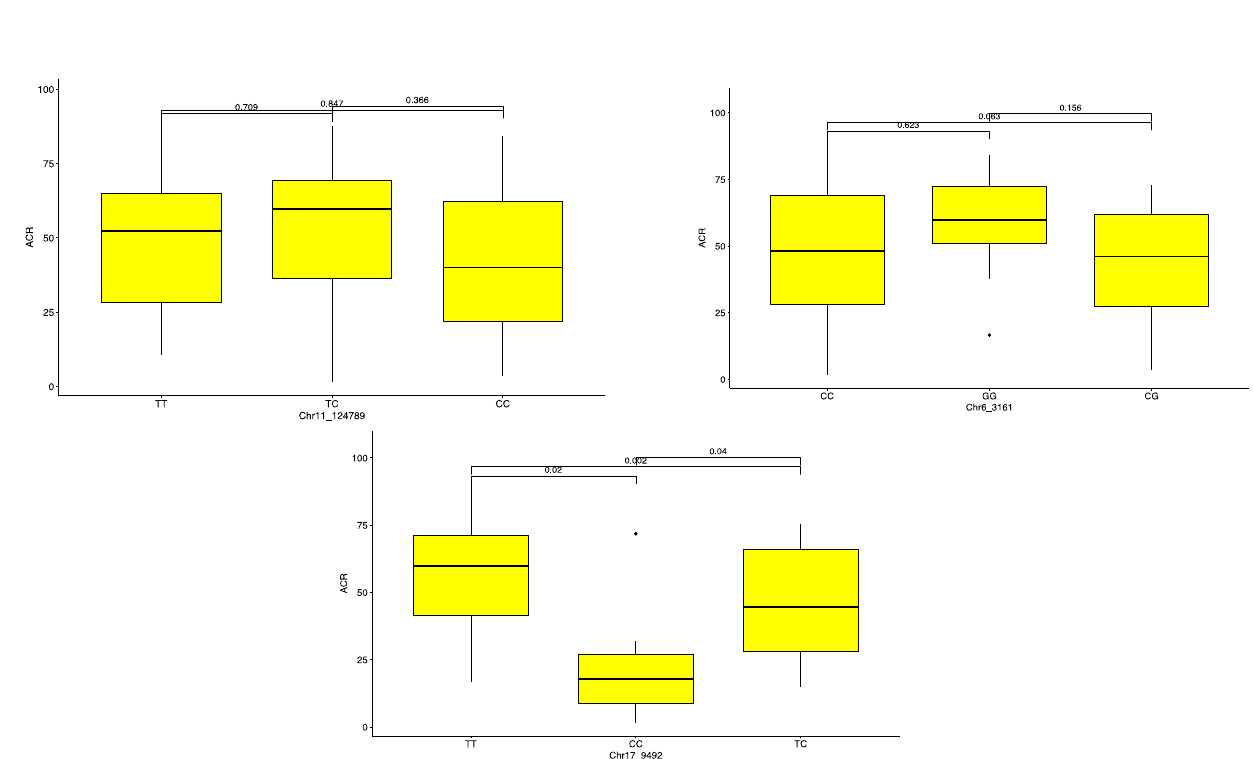
Figure 6. Average crossability rate (ACR) haplotype segregation in D. alata. The boxplots represent the segregation probabilities for each marker.